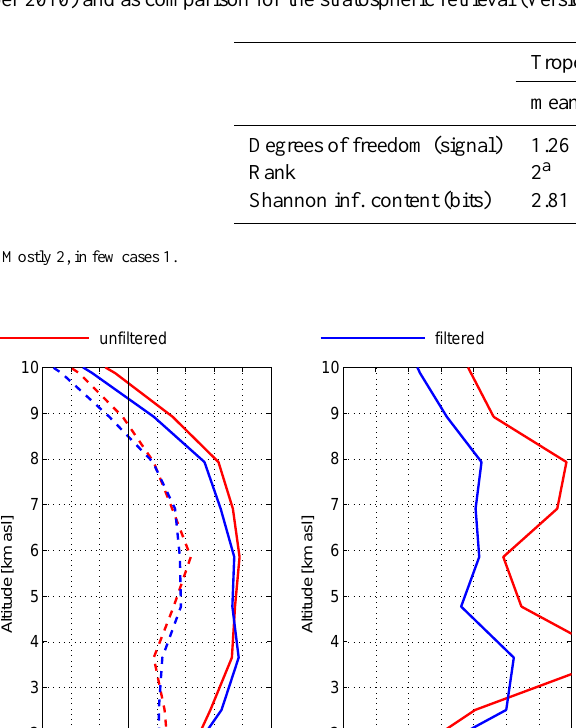
Table 2. Overview of the information content parameters for the tropospheric retrieval (4h averaged spectra, from March 2007 until Octo- ber 2010) and as comparison for the stratospheric retrieval (Version 17, as going into NDACC, from March 2007 until October 2010)